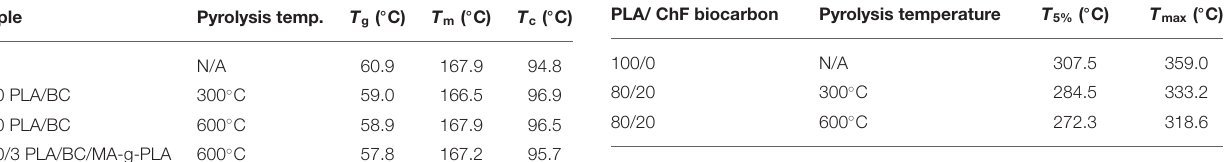
TABLE 5 | Thermal results obtained from digital scanning calorimetry for neat polymer and composites. Sample